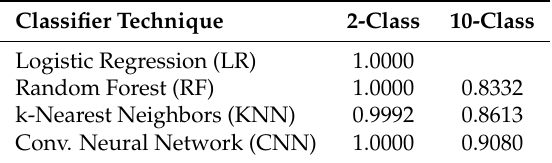
Table 1. Accuracy of classifiers, 2-class and 10-class problems.